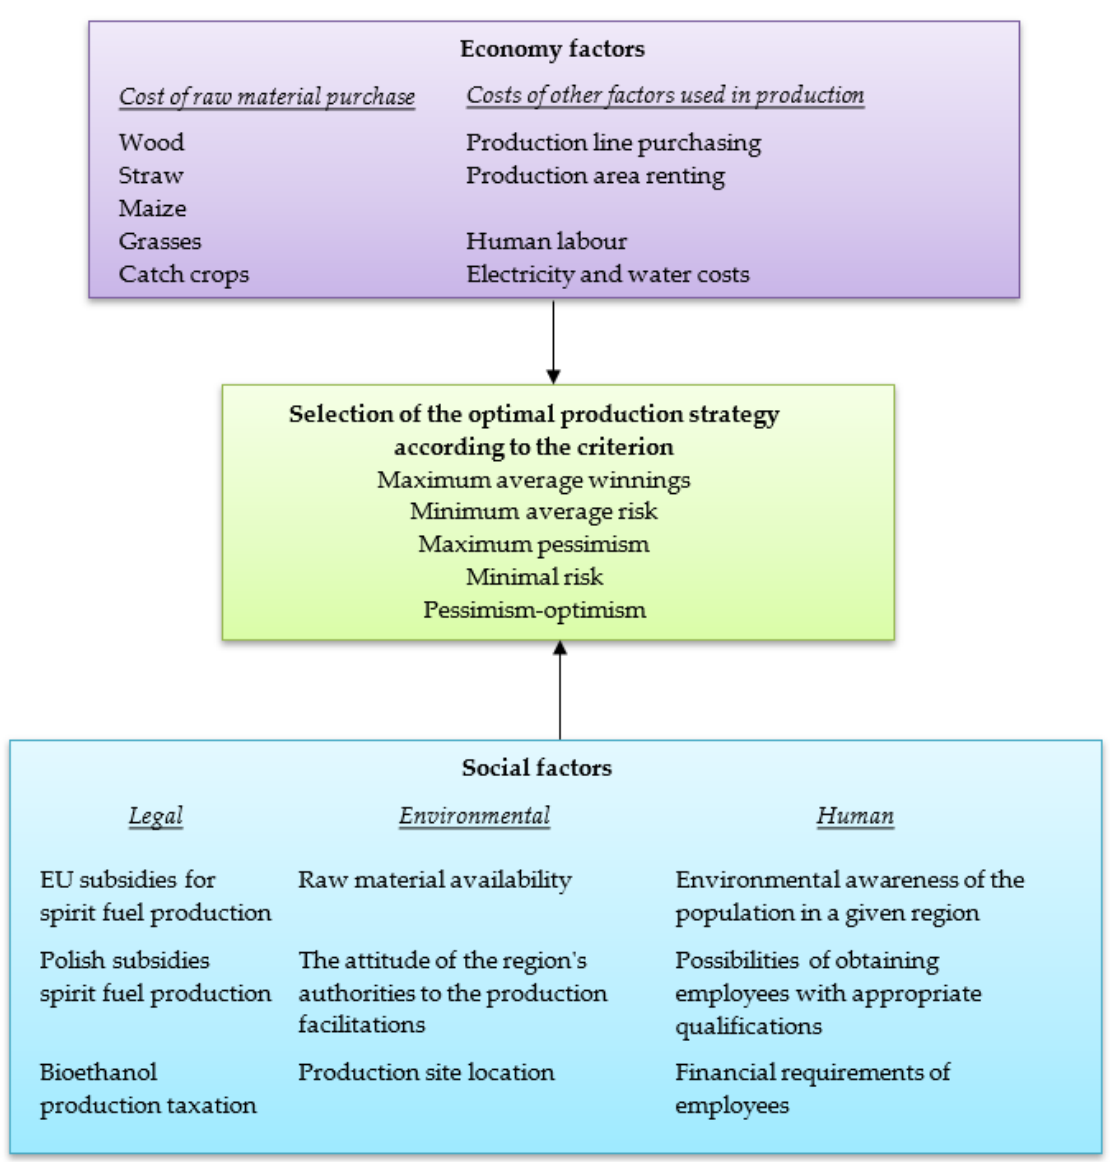
Figure 3. The set of economic and social factors influencing the selection of the most appropriate strategy for second-generation bioethanol production in Poland.